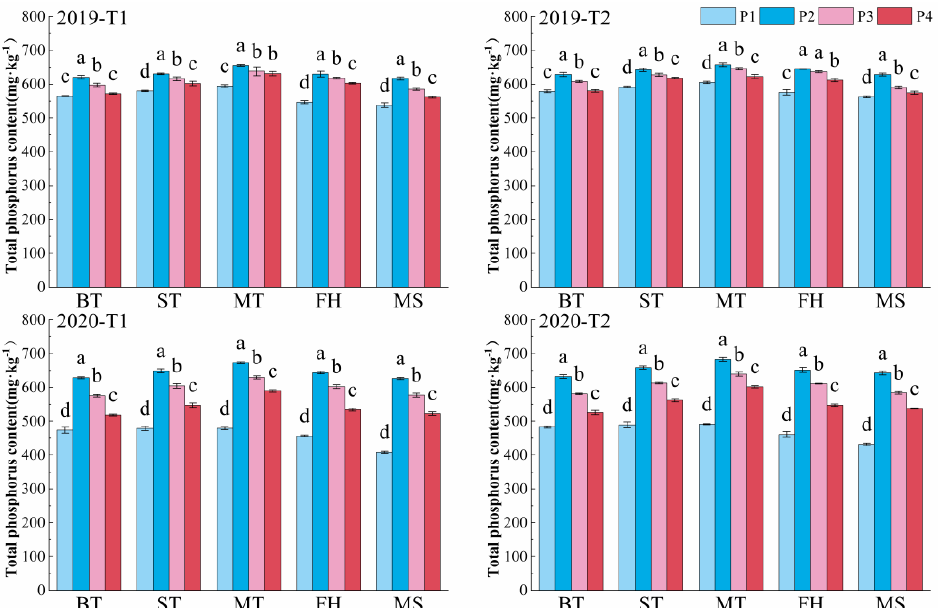
Figure 4. Soil total phosphorus under different treatments in 2019 and 2020. Note T1, no straw re-